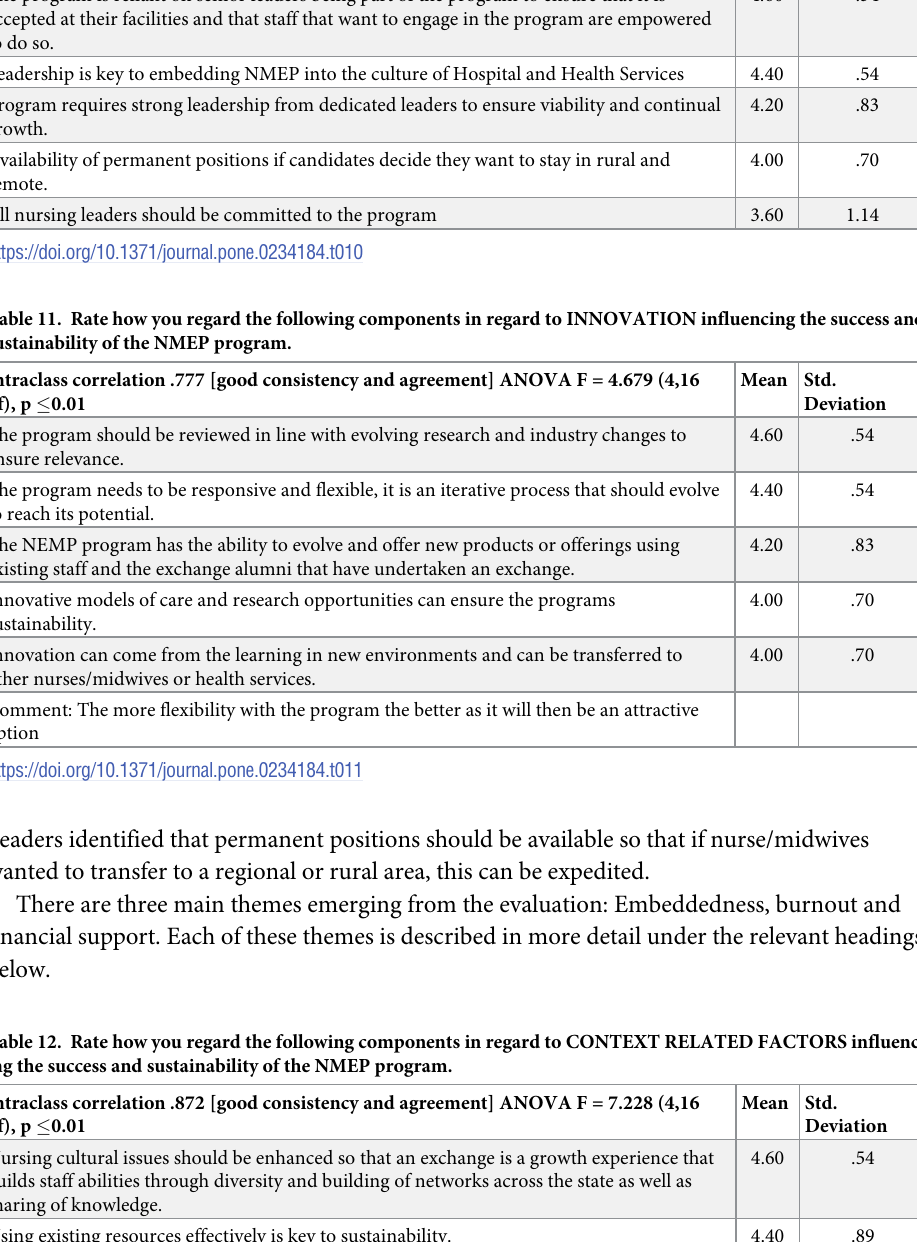
Mean Std. Deviation